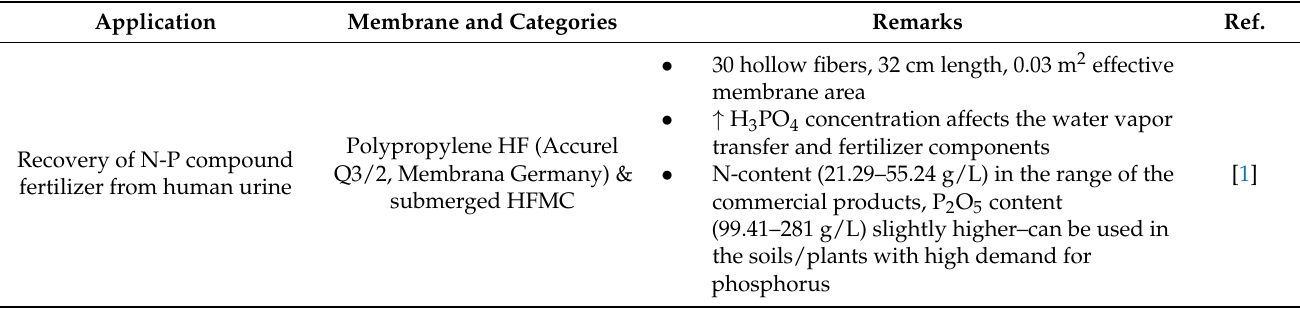
Table 2. Recent development in wastewater treatment using hollow fiber membrane for wastewater treatment and resource recovery.